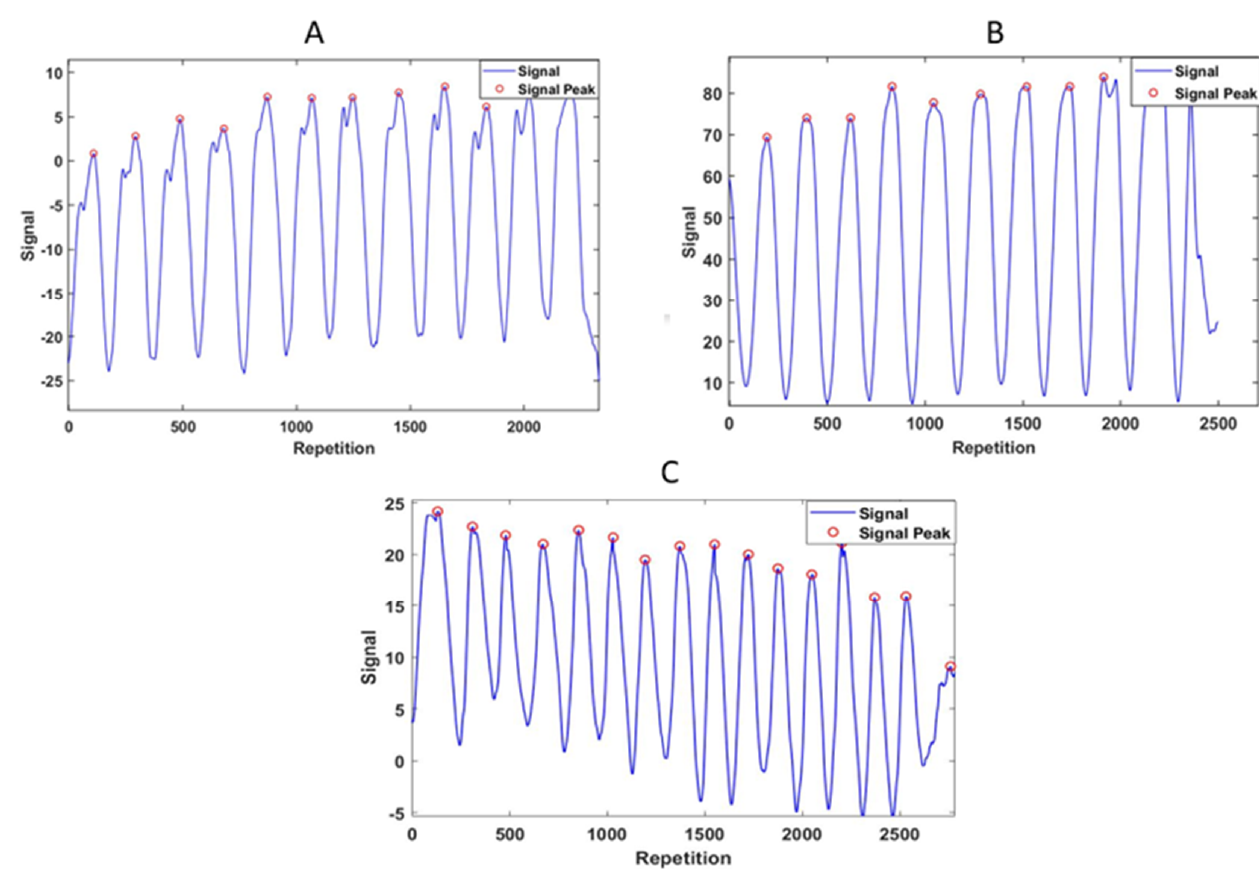
Figure 8. Sample repetition counting models: ( A ) Hammer Curl, ( B ) Squat, ( C ) Pullove.